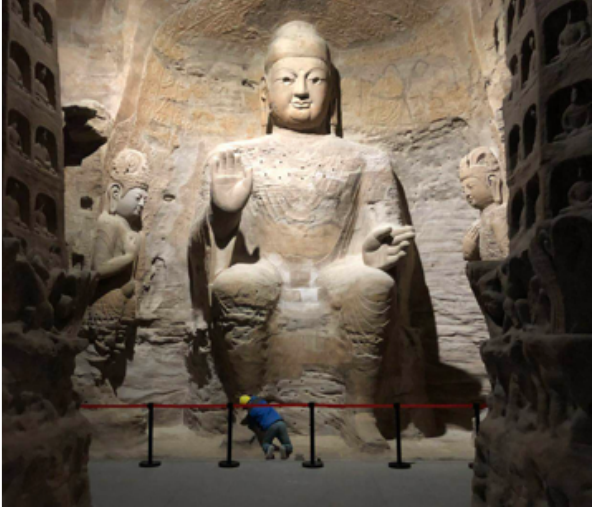
Figure 7. The full view of the replica Cave 3 of the Yungang Grottoes. A painter is refining the details of the bottom part.